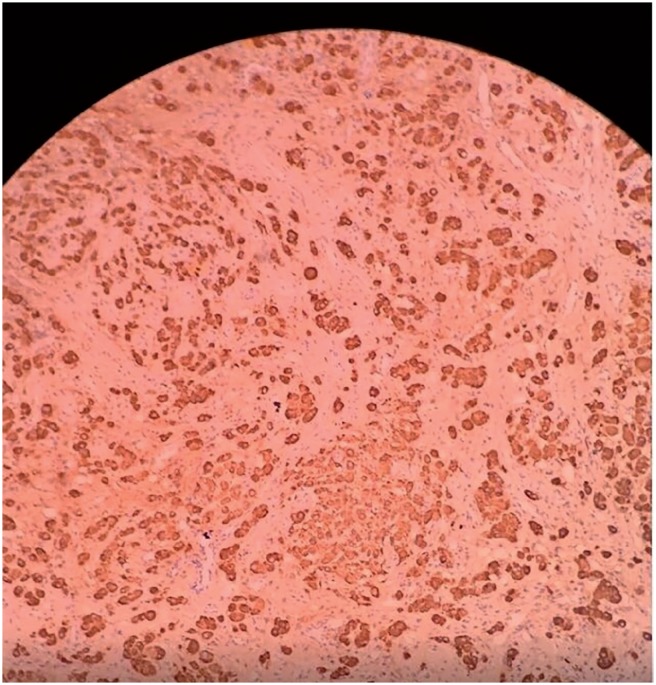
Inhibin antibody (4x).